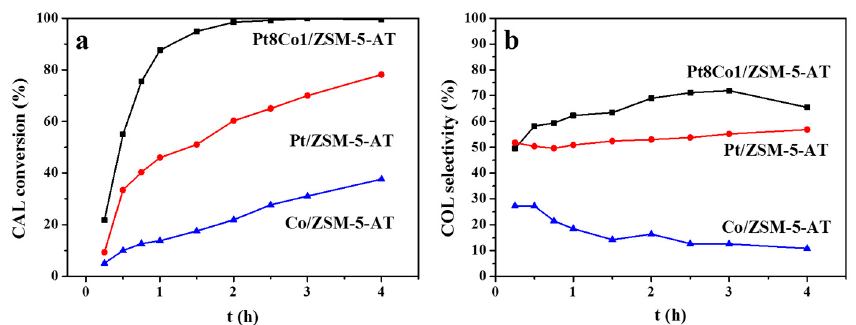
Figure 7. The catalytic results for the selective hydrogenation of CAL over the Pt8Co1/ZSM-5-AT, Pt/ZSM-5-AT, and Co/ZSM-5-AT catalysts: ( a ) CAL conversion and ( b ) COL selectivity. Reaction conditions: 200 mg of catalyst, 4 mmol of CAL, P H2 = 2 MPa, 20 mL of ethanol, at 100 °C, with a stirring rate of 1000 rpm.